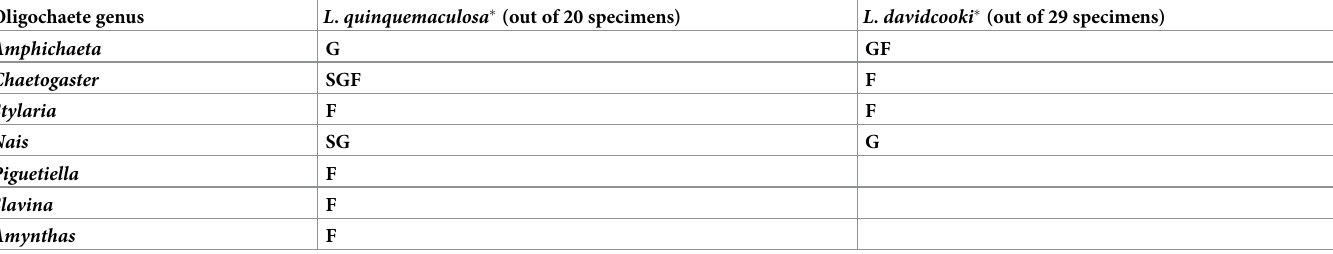
� Shown only for sequence clusters accounting for > 0.1% of non-mite DNA sequences. Key to abbreviations: S, > 96.5% identity; G, 90% to 96. 5% identity; F, 80 to 90% identity to “best hit” GenBank reference